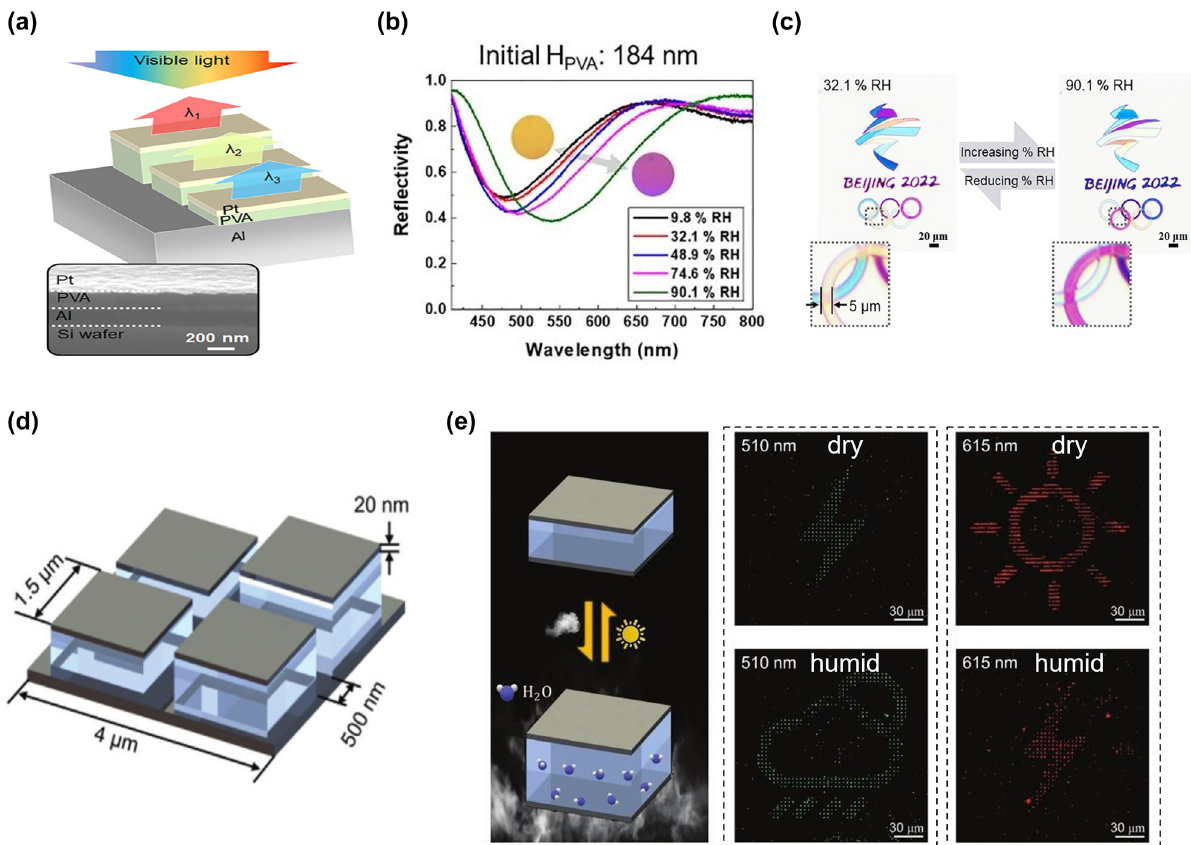
Figure 31: Dynamic structural color generation based on cavity length modulation using a humidity-swelling polyvinyl alcohol (PVA) layer. (a) Schematic diagram of a metal–insulator–metal (MIM) structure with spatially-varying insulator thickness for multi-color display. Inset shows the cross-sectional SEM image of stacked Pt/PVA/Al layers on a Si substrate. (b) Reflection spectra under normal incidence as the ambient humidity varies from 9.8% to 90.1% relative humidity (RH). Insets: corresponding colors at 32.1% and 90.1% RH. (c) Photos of a colored logo of the Beijing 2022 Olympic Games as the humidity is switched between 32.1% and 90.1% RH. Reproduced with permission [321]. Copyright 2021, Walter de Gruyter GmbH. (d) Schematic diagram of a super-pixel (4 × 4 μ m 2 ), comprising four stepwise metal–hydrogel–metal (MHM) sub-pixels (1.5 × 1.5 μ m 2 ) with different cavity (PVA) thicknesses. The thicknesses of both top and bottom Ag layers are 20 nm. (e) Experimentally captured, single-colored images of the PVA-based nano-printing under dry (top) and humid (bottom) conditions. Modified with permission [322]. Copyright 2022,